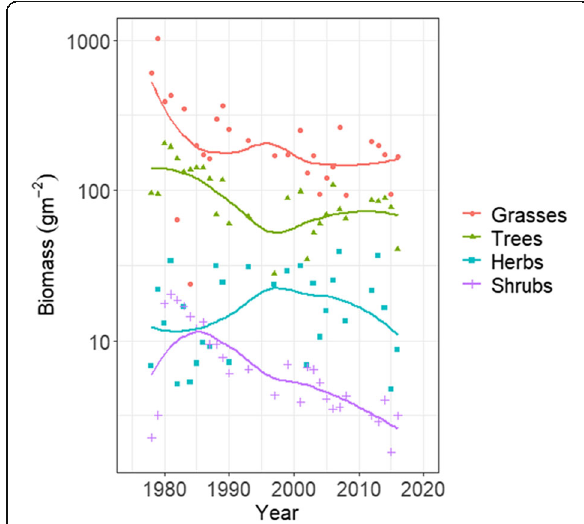
Fig. 4 Average biomass density changes in trees, shrubs, herbs, and grasses between 1977 and